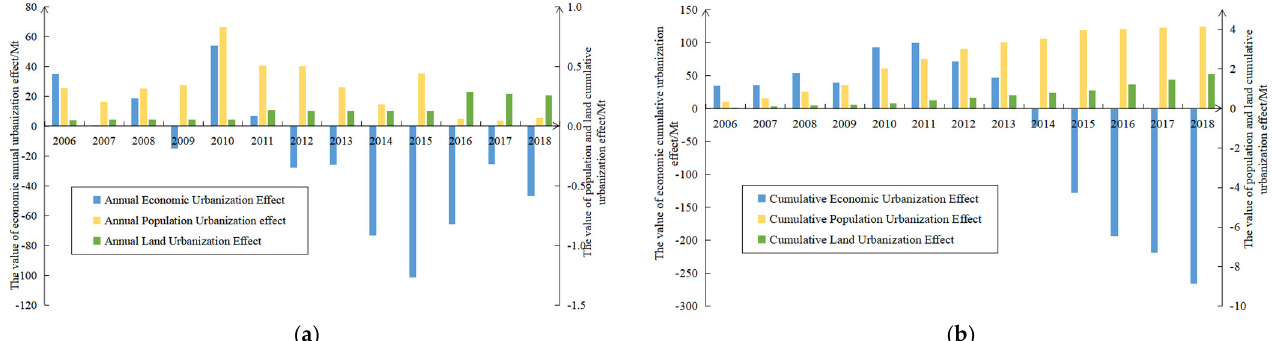
Figure 4. ( a ) Annual effect of urbanization in the Yangtze River Economic Belt; ( b ) Cumulative urbanization effect of the Yangtze River Economic Belt [source: own illustration].